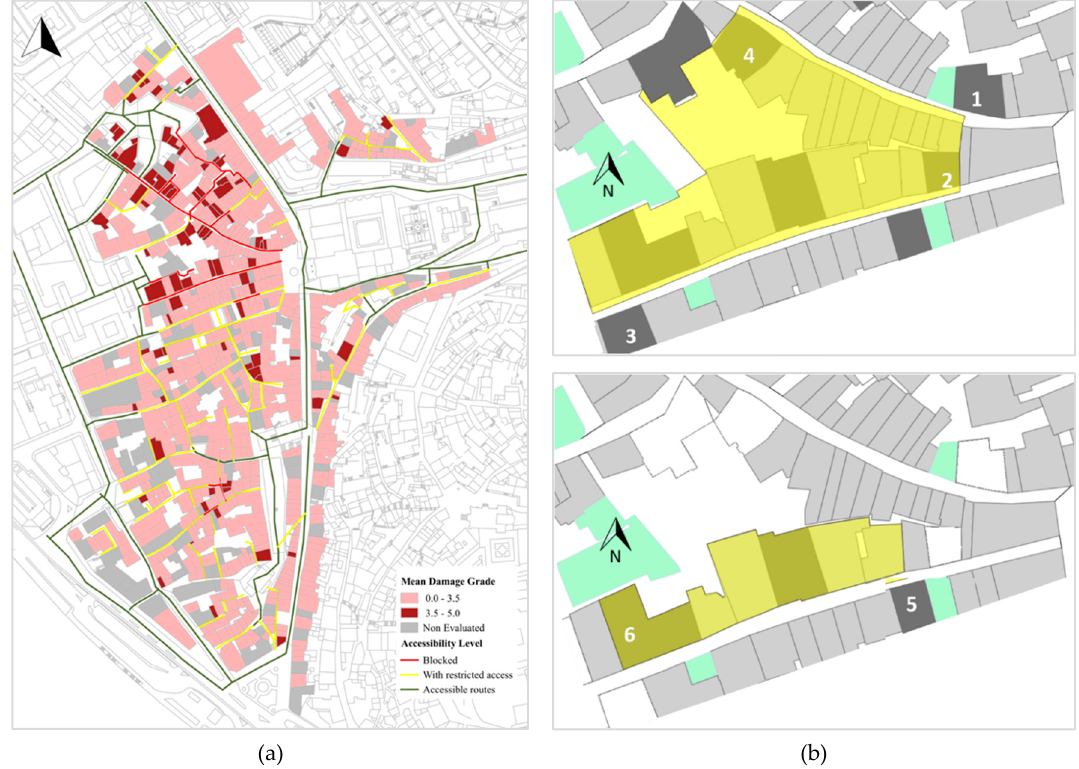
Figure 4. Mapping of ( a ) evacuation routes and ( b ) configuration of the most critical urban area before (top) and after (bottom) retrofit, adapted from Aguado et al. [31].